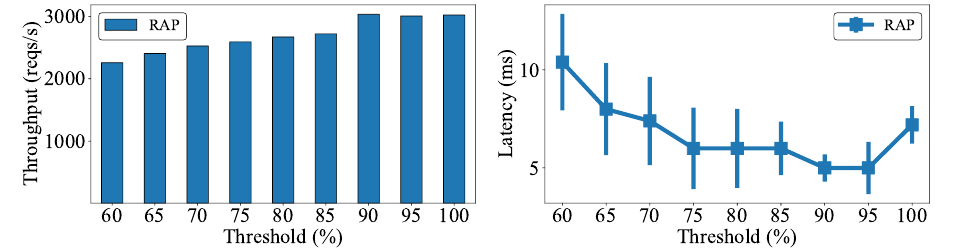
Figure 5. Effect of threshold on cluster